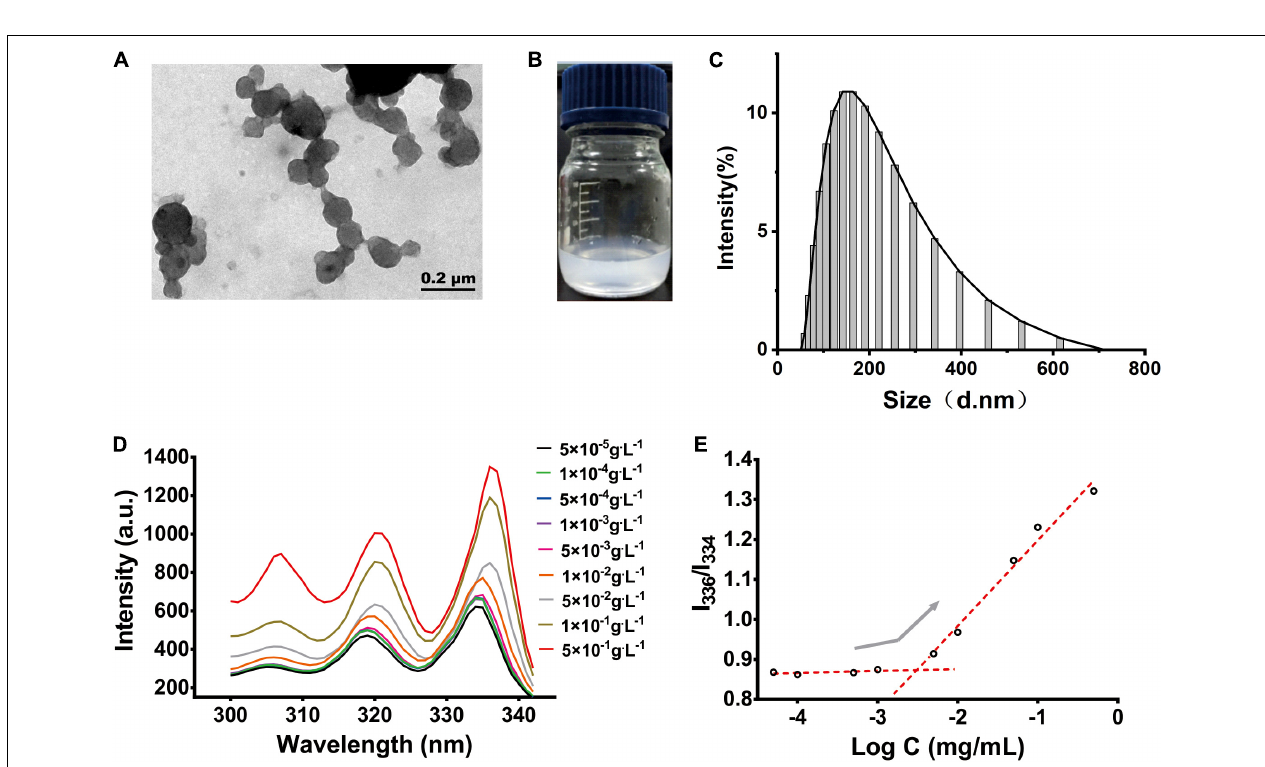
FIGURE 3 | The characterization of PF NPs. (A) TEM image. (B) Eye size of PF NPs (0.2 mg/mL) dispersed in water. (C) Size distribution. (D) Fluorescence excitation spectrum. (E) CAC determinations of PLEL.